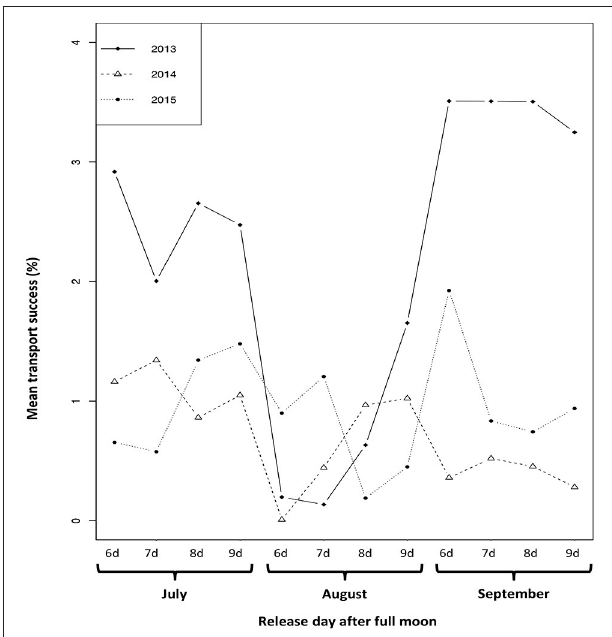
FIGURE 3 | Mean transport success (percentage) of M. cavernosa larvae per month and year of release averaged over West FGB, East FGB, Bright, Geyer, and Mc